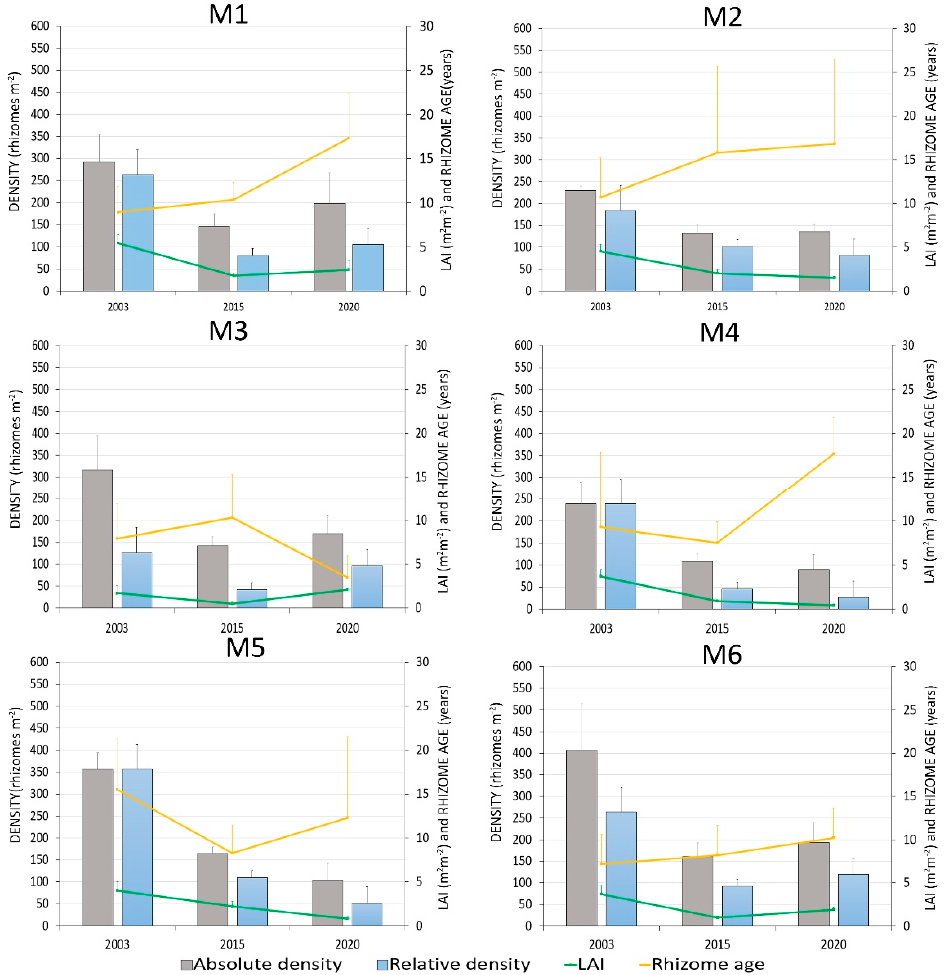
Table 3. Differences in p -values ( t -test) between different years of monitoring within each sam- pling station.